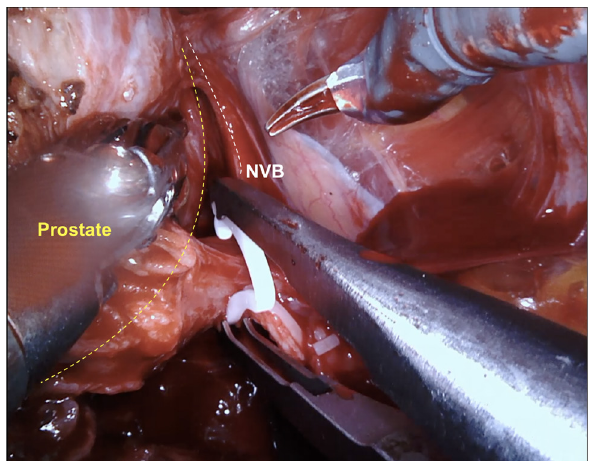
Figure 6 - Anterior lateral prostatic dissection at the artery topography until communicating the lateral and posterior